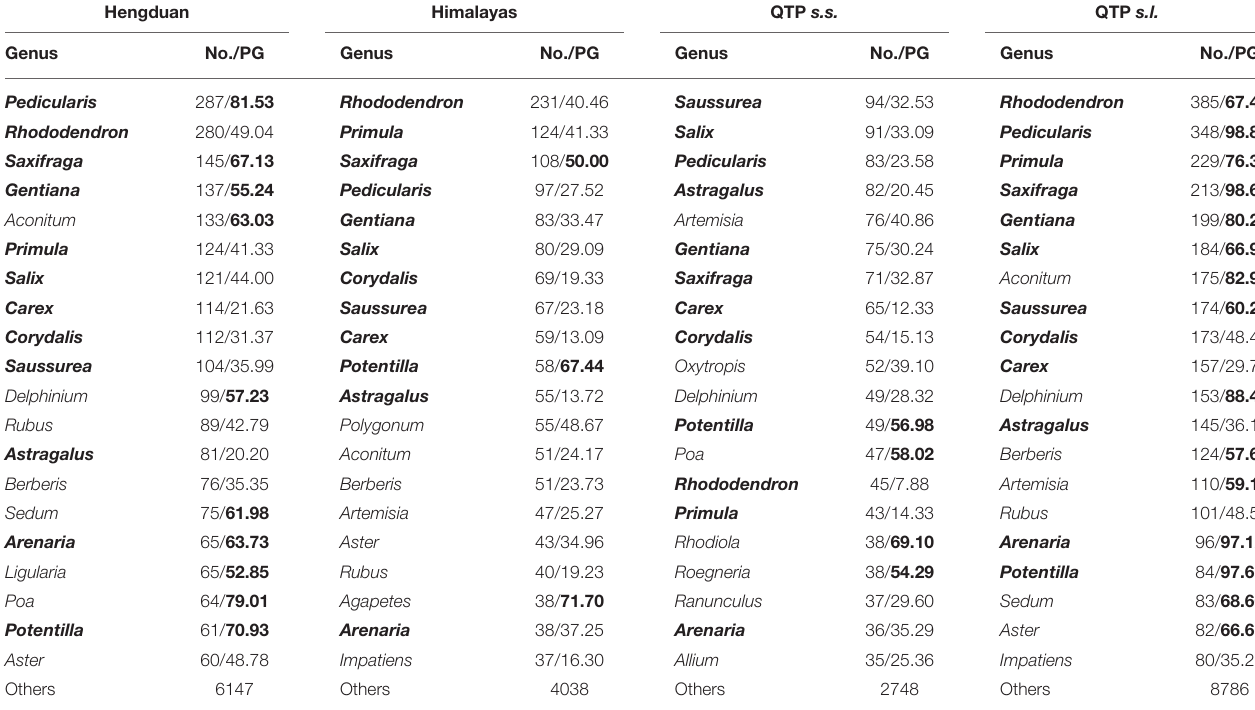
TABLE 4 | Top 20 big genera for the Hengduan Mountains, the Himalayas, the Qinghai-Tibet Plateau s.s. , and the Qinghai-Tibet Plateau s.l. and their percentage of species in their respective genus in China